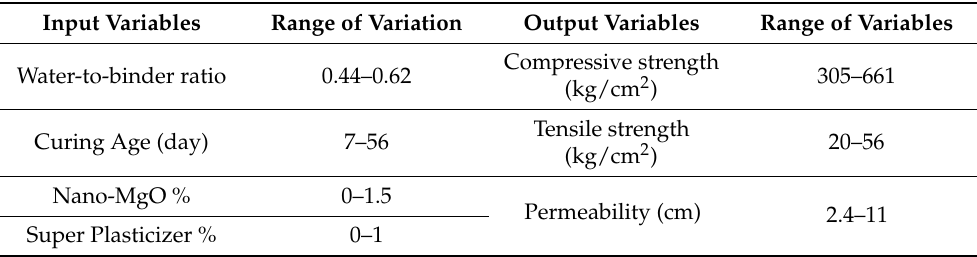
Table 6. Input and output variables and range of